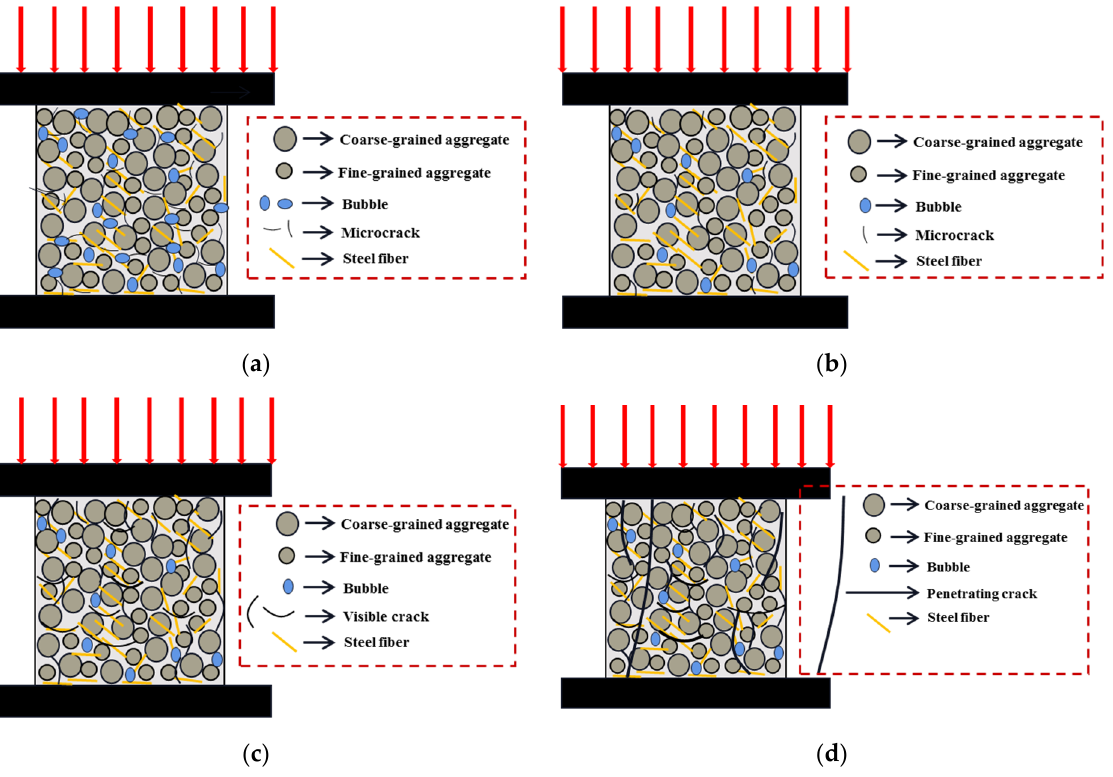
Figure 8. Schematic diagram of the compression stage of the specimen. ( a ) Compression stage; ( b ) Linear enhancement stage; ( c ) Defect expansion stage; ( d ) Destruction stage.